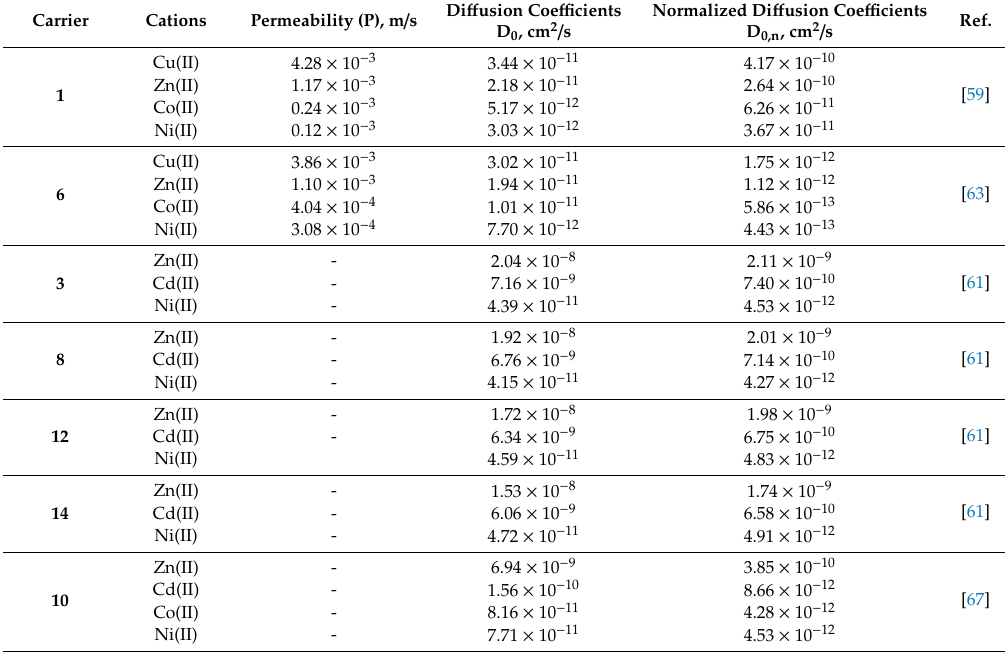
Table 16. Diffusion coefficients for the transport of non-ferrous metal ions across PIMs with alkylimidazoles.